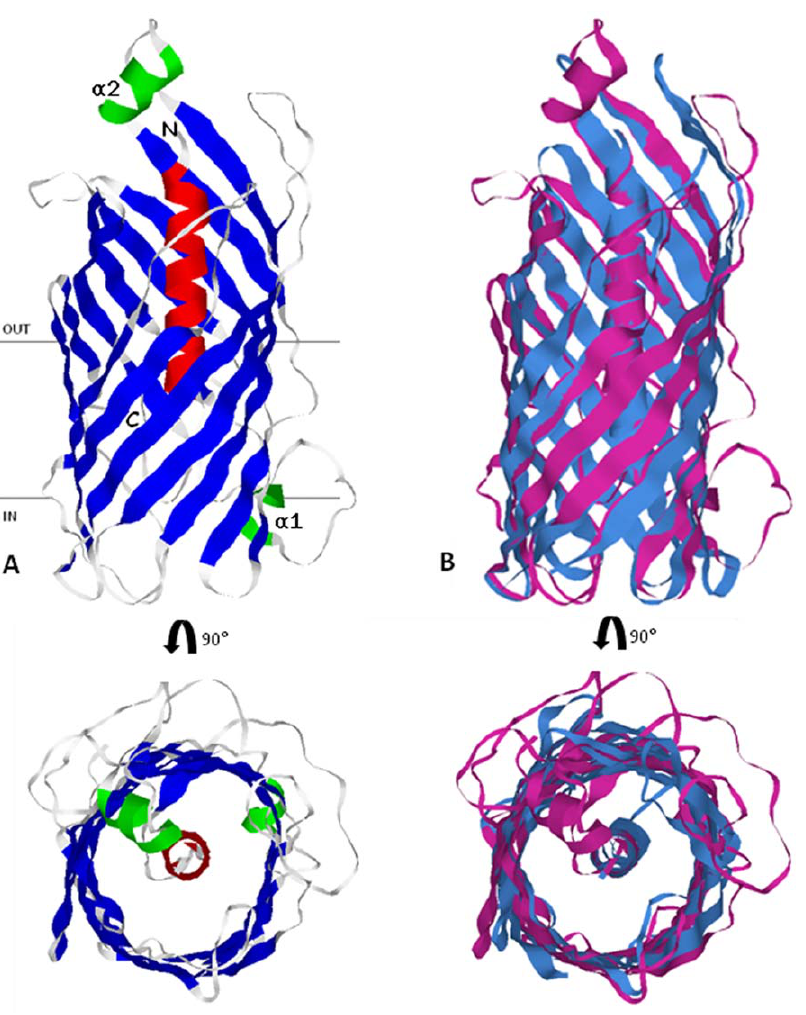
Figure 1. Predicted 3D model of DUF3233. A ) The predicted structure resembles the beta-barrel translocation unit of autotransporter proteins. The 12 beta-strands (blue) orient in anti-parallel fashion enclosing the N-terminal helix (red), the two additional helices a 1 and a 2 are shown in green. B ) Superimposed structures of DUF3233 (magenta) and NalP translocation unit of N. meningitidis 1uyn_x (blue). Figures were generated with Rasmol.